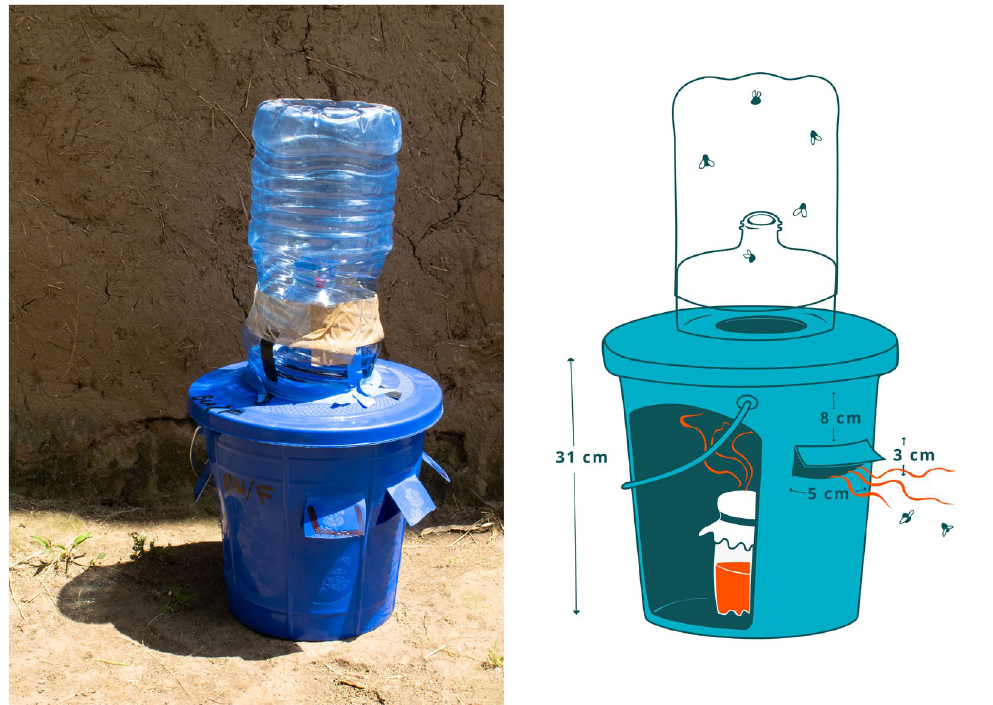
Figure 4. Bickford Bucket (BB) trap, a homemade trap designed from a 5-L water bottle and a bucket. Inside the bucket, a lure is presented in another (250 mL) water bottle, covered with mesh. Image courtesy of Iain Robinson